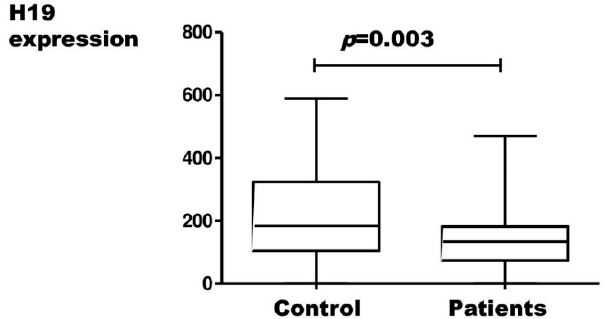
Figure 1. Expression of H19 in endometriosis patients and controls (Mann–Whitney test; p < 0.05).